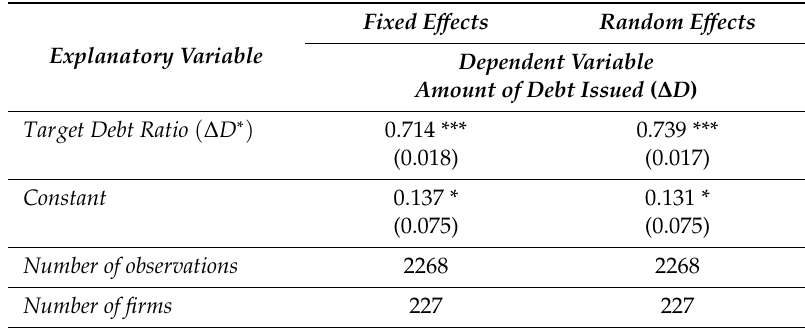
Table 6. Estimation Results of the Target Adjustment Model.